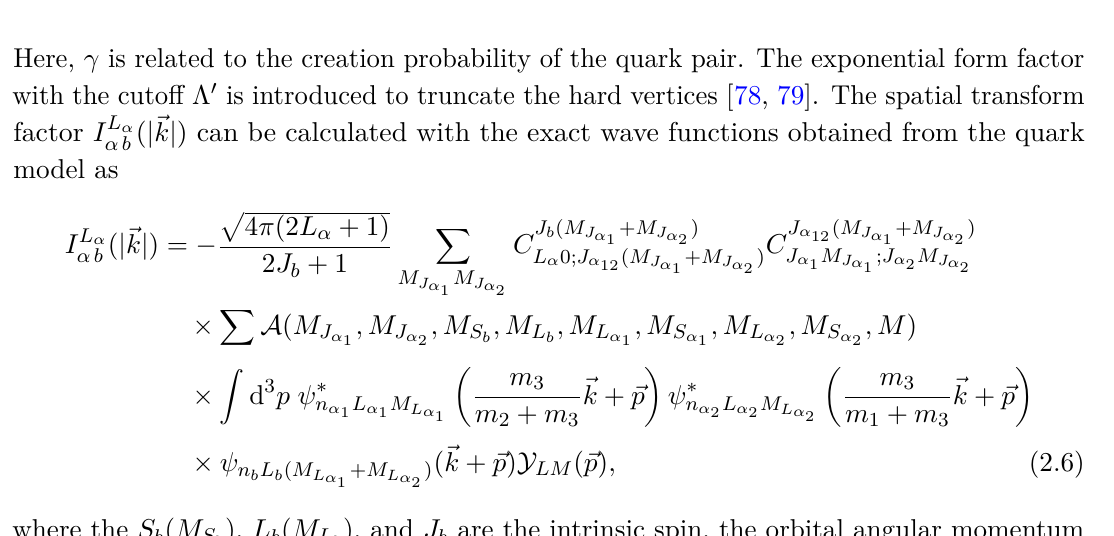
Figure 2 . The diagram contributes to the process of the bare state coupling to B ( ∗ ) ¯ K channel in the QPC model. The first and second quarks are anti-strange and bottom quarks, respectively. The third and fourth are the light quarks created from a